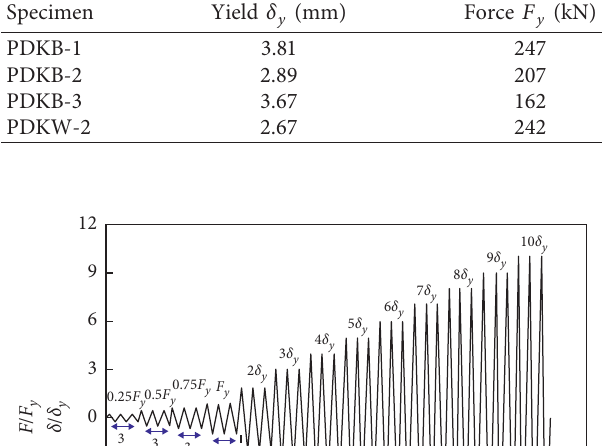
Table 6: Yield displacement and corresponding force. Specimen